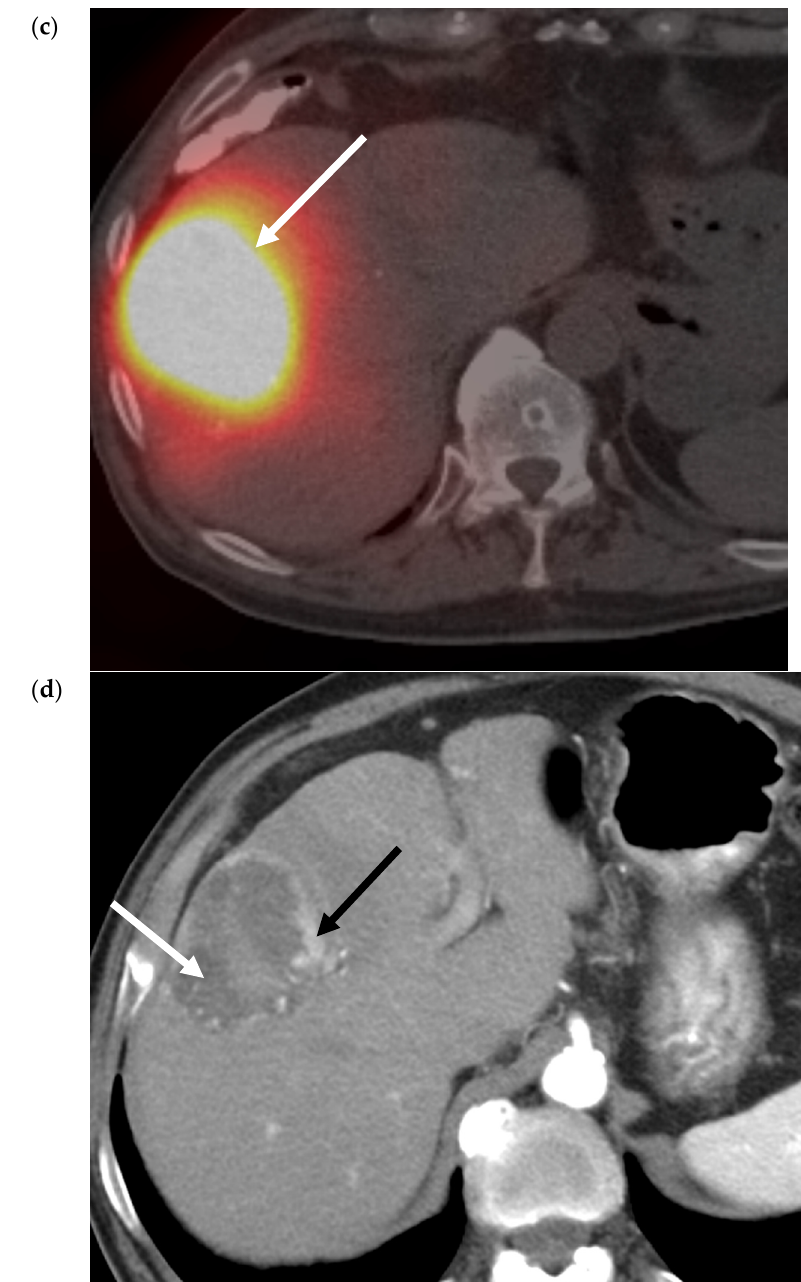
Figure 4. 90Y Radiation Segmentectomy for Solitary HCC. ( a ) Pre-procedure triphasic contrast-enhanced CT in the hepatic arterial phase. Mass (white arrow) with arterial hyperenhancement in the anterior sector of the right lobe of the liver, consistent with solitary HCC. ( b ). Digital subtraction angiogram of the anterior division of the right hepatic artery prior to administration of glass 90Y microspheres. Mass (white arrow) is supplied by the anterior division of the right hepatic artery (black arrow). ( c ) SPECT image immediately post-90Y radioembolization. High activity of 90Y microspheres in the liver tumor (white arrow) is demonstrated without evidence of nontarget delivery. ( d ) Post-procedure triphasic contrast-enhanced CT in the arterial phase performed 6 weeks post-treatment. Marked decrease in arterial hyperenhancement of the anterior right hepatic tumor. Overall, the mass is hypoenhancing (white arrow) due to the treatment effect, with a rim and few areas of residual enhancement (black arrow).